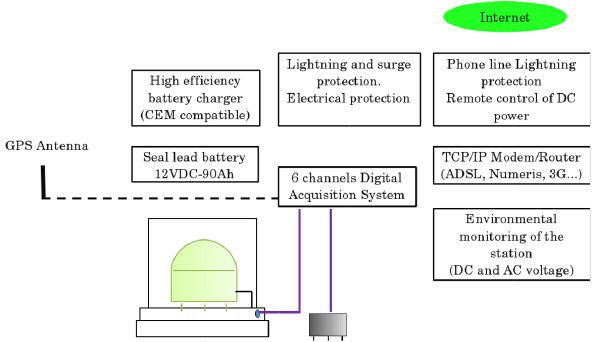
Fig. 3. schematic of our new installations